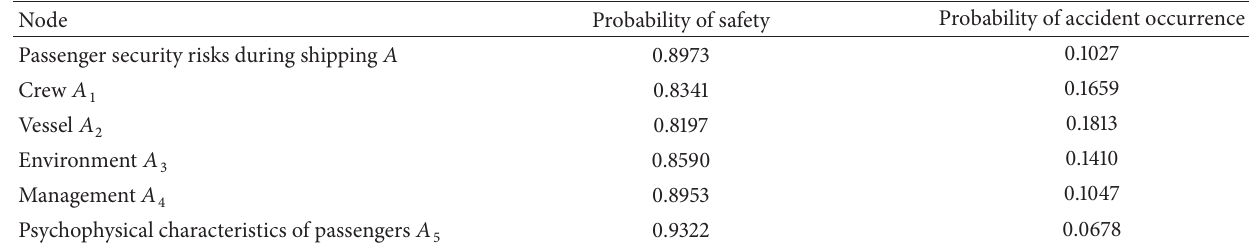
Table 7: Probability of passenger security during shipping and